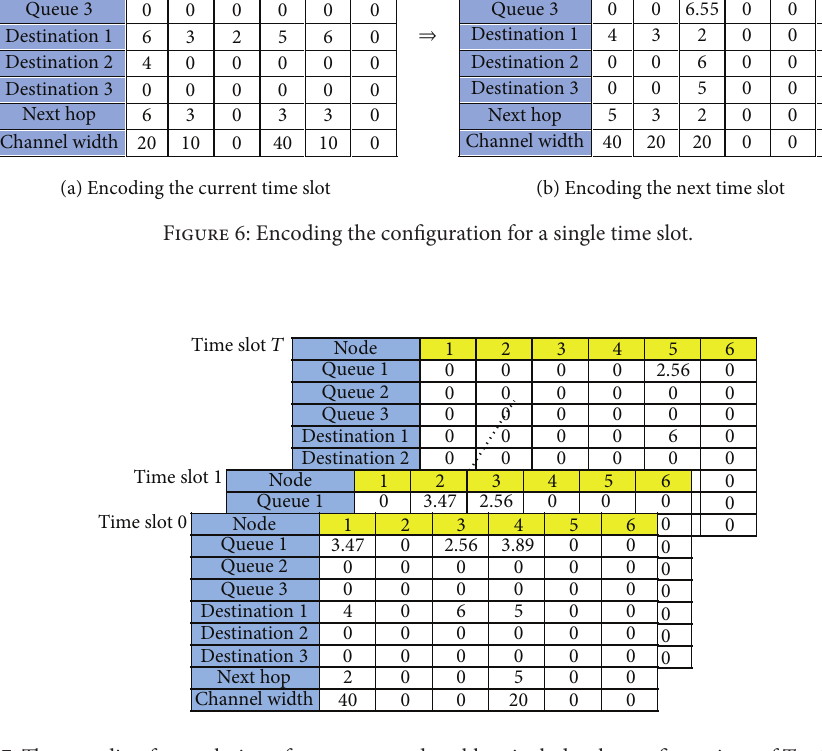
Figure 7: The encoding for a solution of our concerned problem includes the configurations of 𝑇 + 1 time